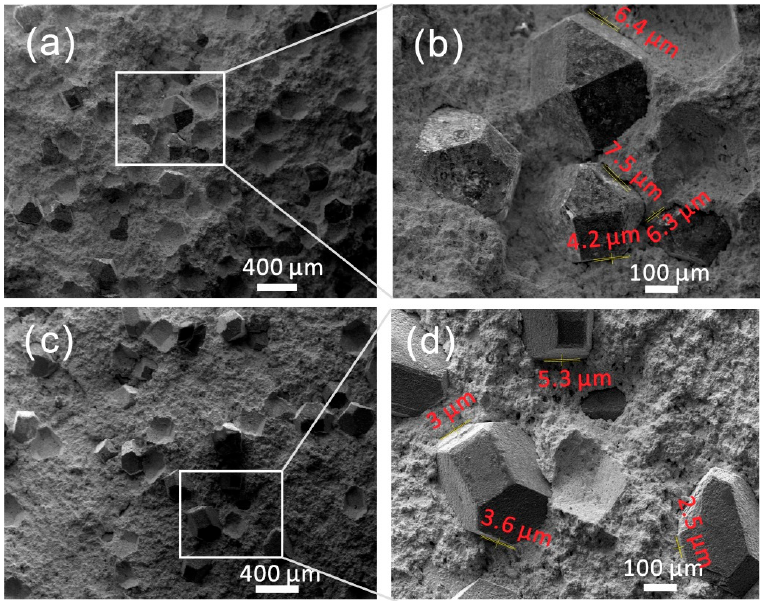
Figure 5. SEM images of fracture faces of samples SD0 ( a , b ) and SD1 ( c , d ). The sizes of crack width were measured in image processing software.